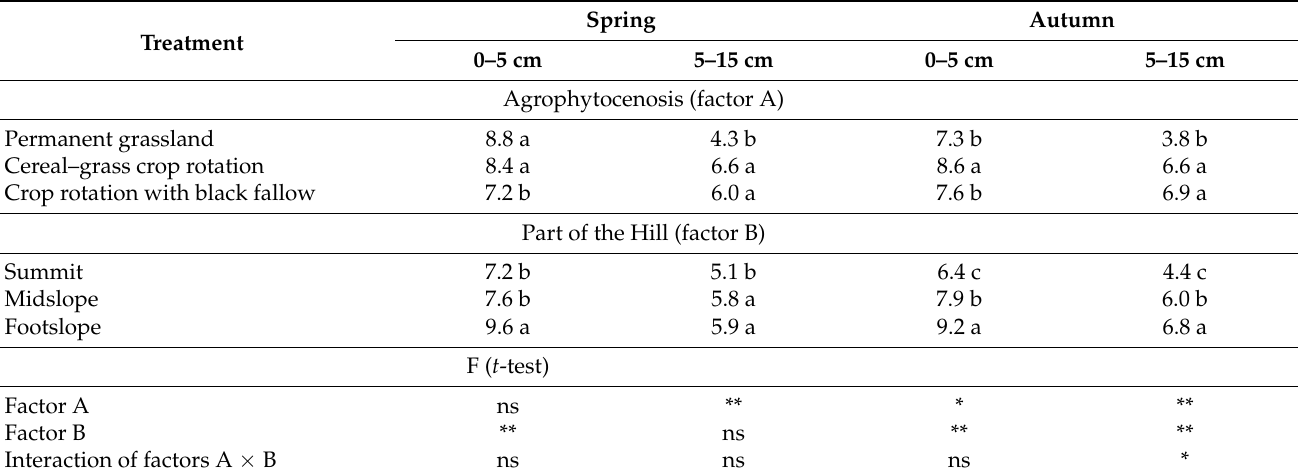
Table 2. Number of seed species in soil,